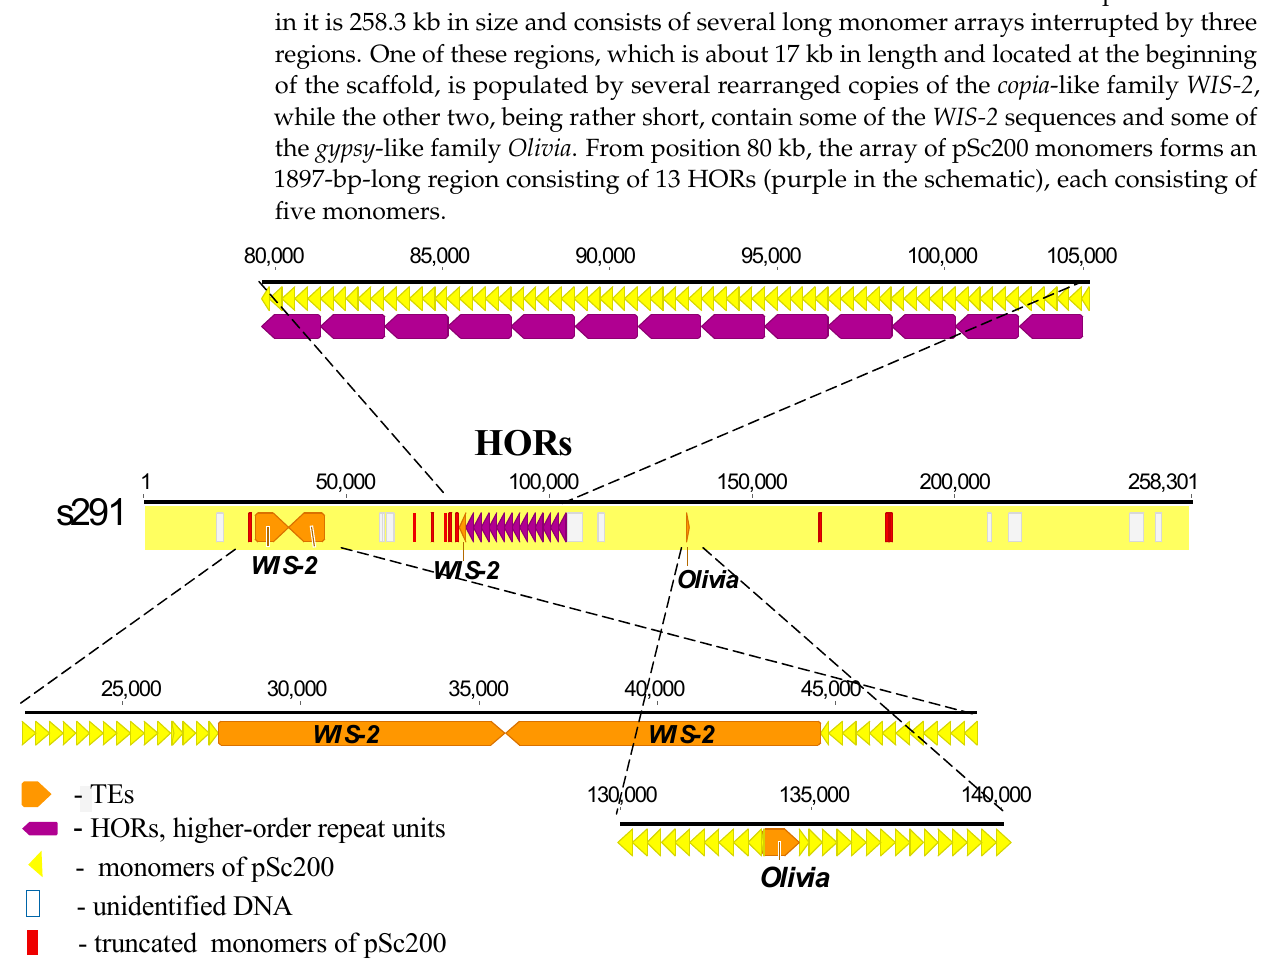
Figure 3. Schematic of the molecular organization of heterochromatin in rye subtelomeres (line ‘Lo7’), with the scaffold s291 as an example. pSc200 monomers (yellow finger-post arrows) and transposable elements (brown finger-post arrows) alternate with pSc200 monomers. Thirteen HOR units, each consisting of five pSc200 monomers, are pointed to by purple arrows. Truncated pSc200 monomers (red rectangles) are scattered along the scaffold with increased concentration near the 5’-ends of the HORs and the truncated copy of WIS-2 . The numbers at the top show distances in kilobases.